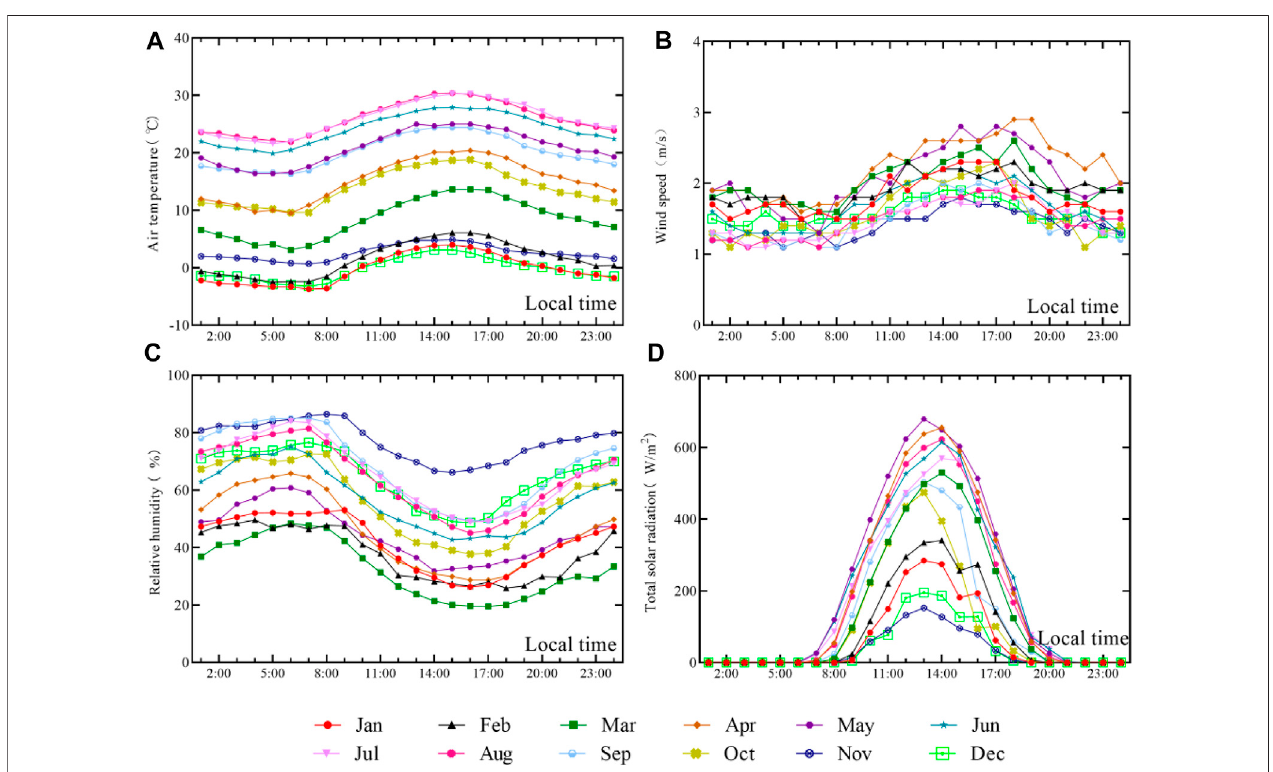
FIGURE 3 | Diurnal variations in (A) air temperature, (B) wind speed, (C) relative humidity, and (D) solar total radiation near the Siyuan Bridge in Beijing in 2015.